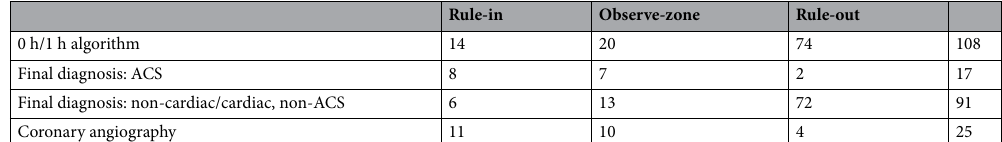
Rule-in Observe-zone